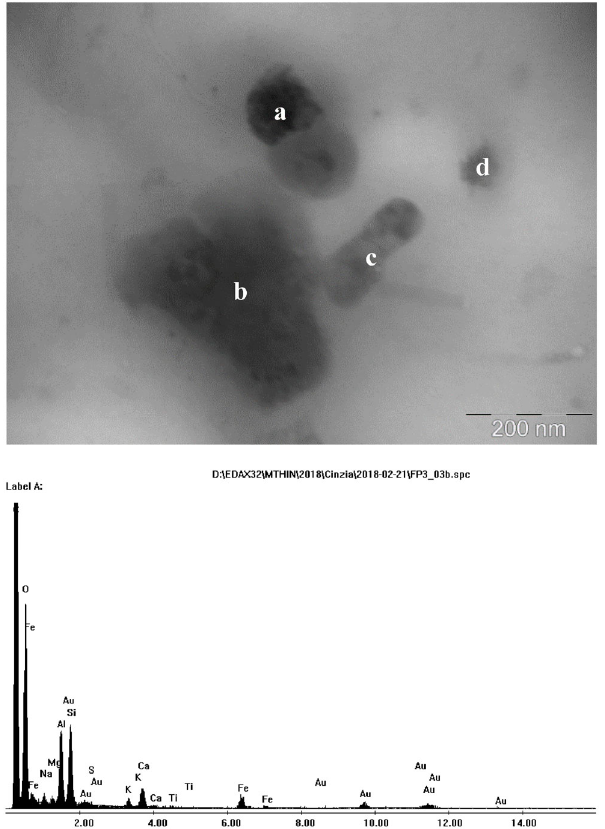
Fig. 12 TEM micrograph showing ultra-fine kaolinite grains, a component of the FM4 pad material, detected on filter stage 3 (average diameter of collected particles: 29 nm). A similar spectrum was found in the other four analyzed spots (a, b, c, and